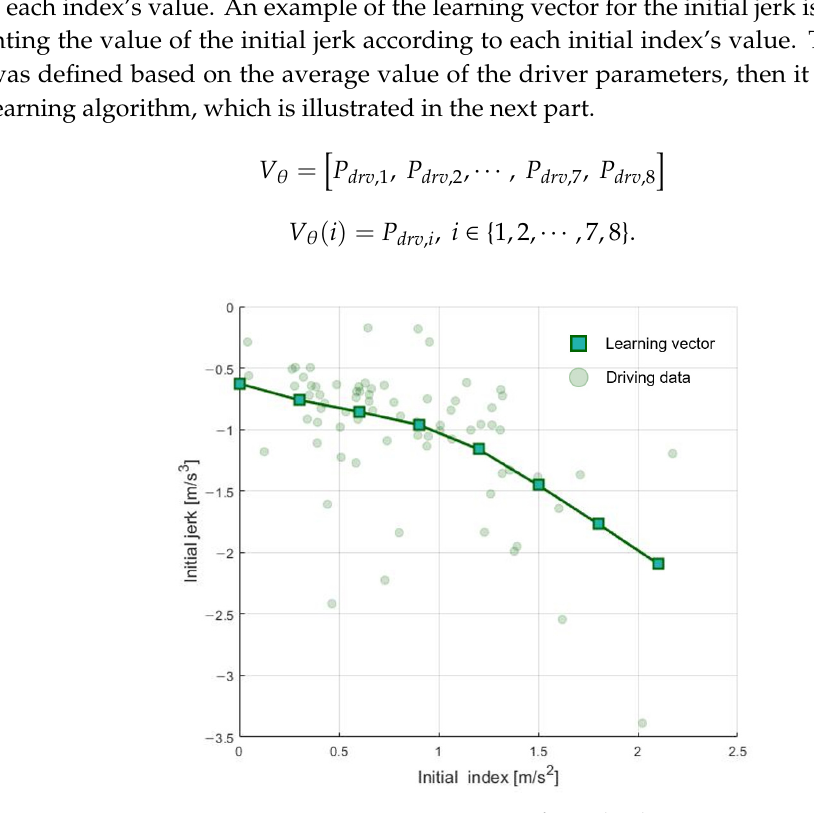
Figure 9. Learning vector of initial jerk. Table 4. Example of learning vector for initial jerk.